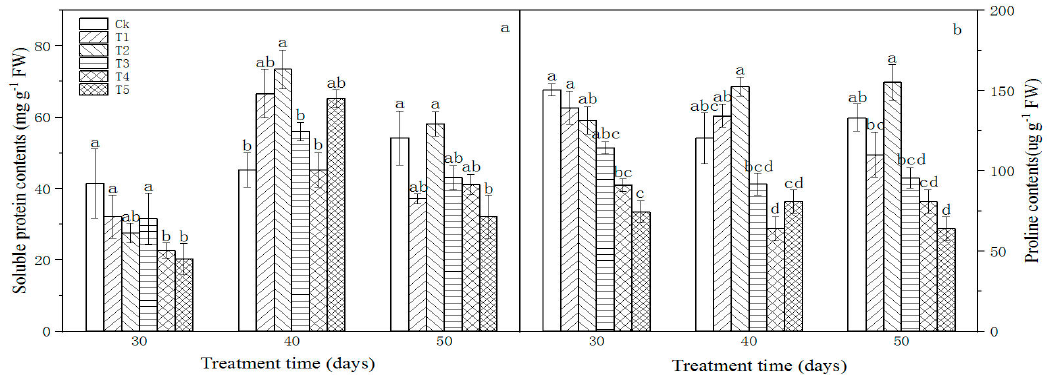
Figure 7. Soluble protein ( a ) and proline ( b ) contents of L. olgensis leaves with different graphene treatments (mean ± 1 S.D., n = 3). FW = fresh mass. Values followed by the same letter for the same days are not significantly different at P < 0.05. Ck, T1, T2, T3, T4, and T5 represent 0, 25, 50, 100, 250, and 500 mg L -1 graphene treatments, respectively.